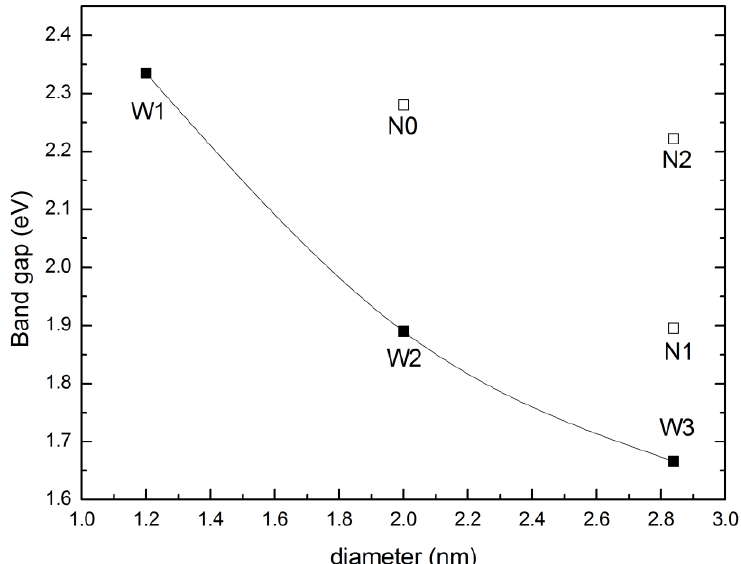
Figure 4. Variation of the band gaps of ZnSe NWs and NTs with the diameter; terms in the figure correspond to the structures shown in Figure